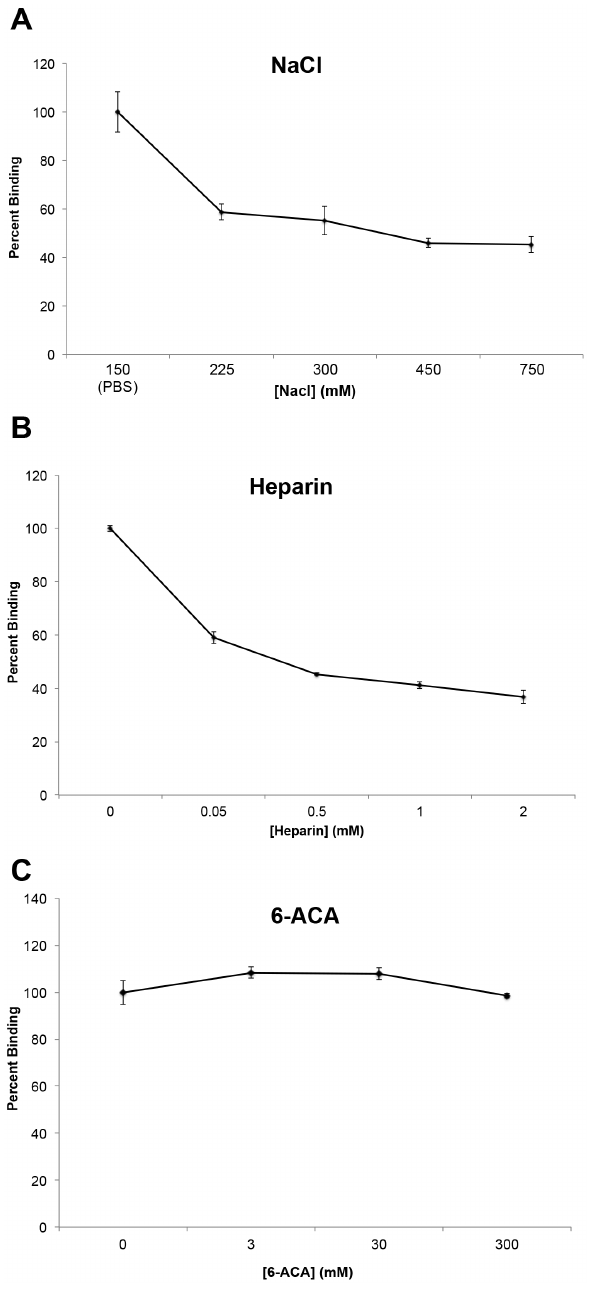
Figure 3. rBB0347-Fn binding is partially dependent on ionic interactions. BB0347 binding to Fn was measured via ELISA as in Fig. 2; except that varying levels of several inhibitors were used. Both NaCl ( A ) and heparin ( B ) inhibited the binding of BB0347 to Fn, while the addition of the lysine analogue 6-ACA ( C ) was not found to have any effect. All values were blanked against BSA. Results are representative of at least three independent experiments with similar results, and at least 4 replicates for each concentration. Error bars indicate 6